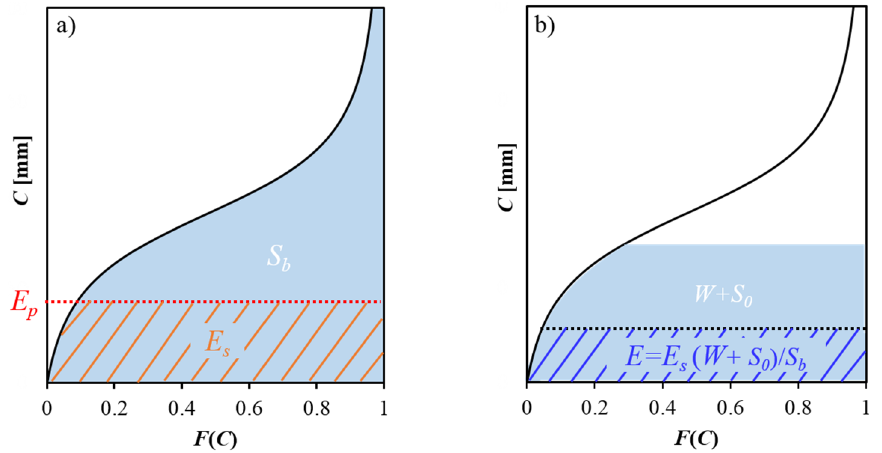
Figure 2. The calculation of evaporation for two cases: ( a ) the entire catchment is saturated; ( b ) the catchment is partially saturated.